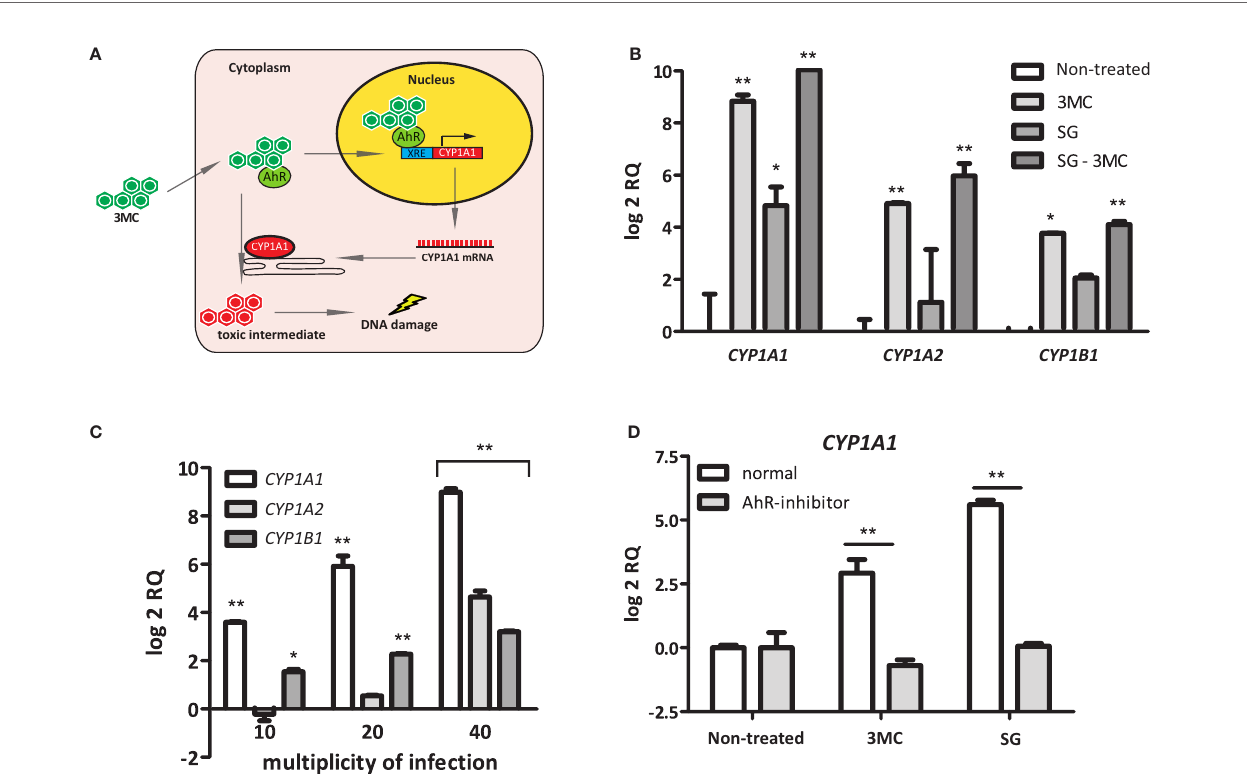
FIGURE 3 | Bacterial Induction of CYP1A1, CYP1A2, and CYP1B1. (A) Model for AhR-dependent gene regulation. Polycyclic aromatic hydrocarbons (PAHs) diffuse into the cell and bind to the intracellular Aryl hydrocarbon receptor (AhR). Next, this complex translocates into the nucleus and binds to an XRE-response element, as present in the CYP1A1 promoter region. After transcription/translation, CYP1A1 acts in the endoplasmatic reticulum as a phase I enzyme that converts PAHs to more toxic intermediates that can form DNA adducts. (B) CYP1A1, CYP1A2, and CYP1B1 induction was investigated in the presence or absence of the AhR ligand 3MC. Note that S. gallolyticus UCN34 (SG) and 3MC have an additive effect on CYP1A1, CYP1A2, and CYP1B1 induction. (C) The expression of CYP1A1, CYP1A2, and CYP1B1 upon incubation with S. gallolyticus UCN34 at increasing multiplicity of infection was compared to non-treated control cells. (D) The induction of CYP1A1 by 3MC or S. gallolyticus UCN34 in HT-29 cells, in the presence or absence of an AhR-inhibitor, was investigated by qPCR. Statistical analysis by two-way ANOVA was performed to determine signi fi cant changes (*p < 0.05; **p <